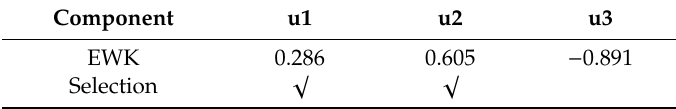
Table 4. The e ffi cient weighted kurtosis (EWK) value of each component.